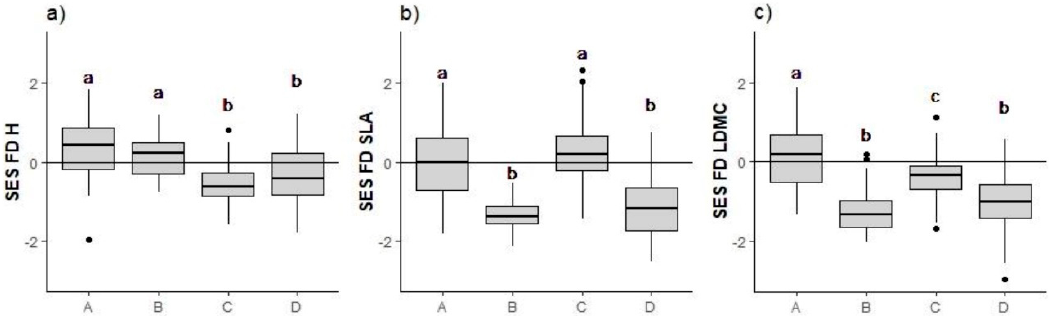
Figure 1. Boxplots comparing the analyzed plant communities in terms of standardized effect size functional diversity (SES-FD) for: ( a ) plant height (SES-FD H ), ( b ) specific leaf area (SES-FD SLA ) and ( c ) leaf dry matter content (SES-FD LDMC ) (A: Leucopoa dimorpha community, B: Sesleria juncifolia community, C: Plantago atrata community, D: Silene acaulis community). Boxplot letters indicate statistically significant differences among communities after Tukey’s post hoc test ( p < 0.05).